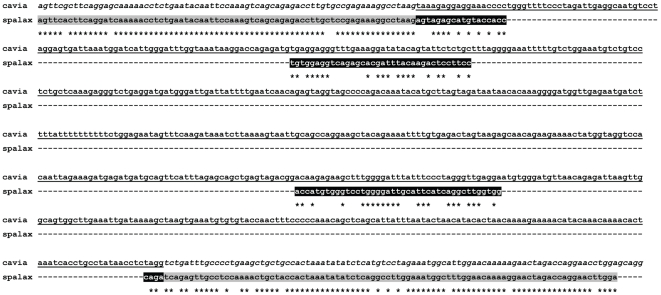
Pairwise alignment of S. galili transcribed insert against the homologous Cavia porcellus melusin genomic region.In order to validate Blast and Lastz indications that the S. galili novel transcribed regions are non-conserved in target genomes we locally aligned the Spalax insert as well as the conserved flanking regions to the target genome. (see Methods). An example is shown above for the putative novel transcribed region in the Spalax melusin transcript (isotig19920). The highly conserved flanking regions (gray blocks) mapped to target regions harboring Cavia exons 4 and 5. The novel Spalax transcribed region (black blocks) is only weakly aligned to the Cavia intronic region, indicating that a homologous exon is probably missing in the target genomic region. Similar alignments were constructed for different target mammals in order to decrease the probability of false positive detection of novel exons. The Cavia exons are labeled in italics. The Cavia intron is underlined.